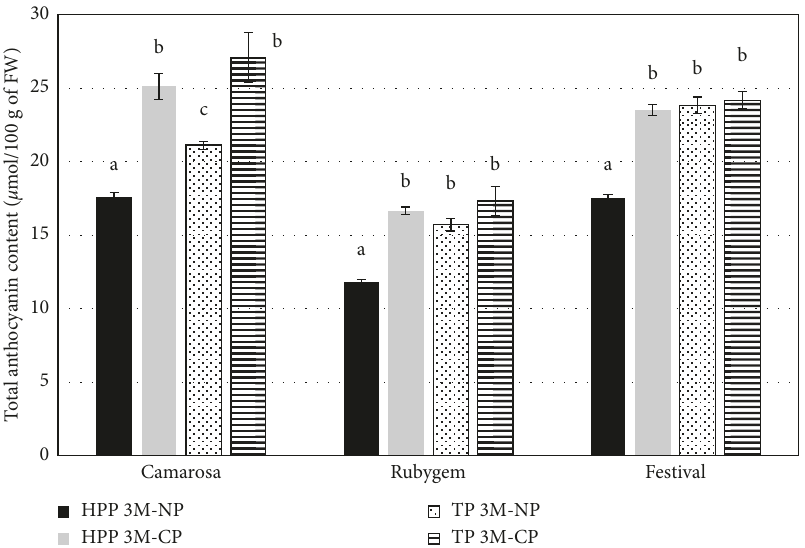
Figure 1: The effects of copigmentation on anthocyanin content of high-pressure- (HPP) and thermally processed (TP) strawberry puree samples after three months of refrigerated (4 ° C) storage. CP-3M: copigmented samples and NP-3M: non-copigmented samples stored for three months at 4 ° C. Different letters within a group designate a significant difference ( p